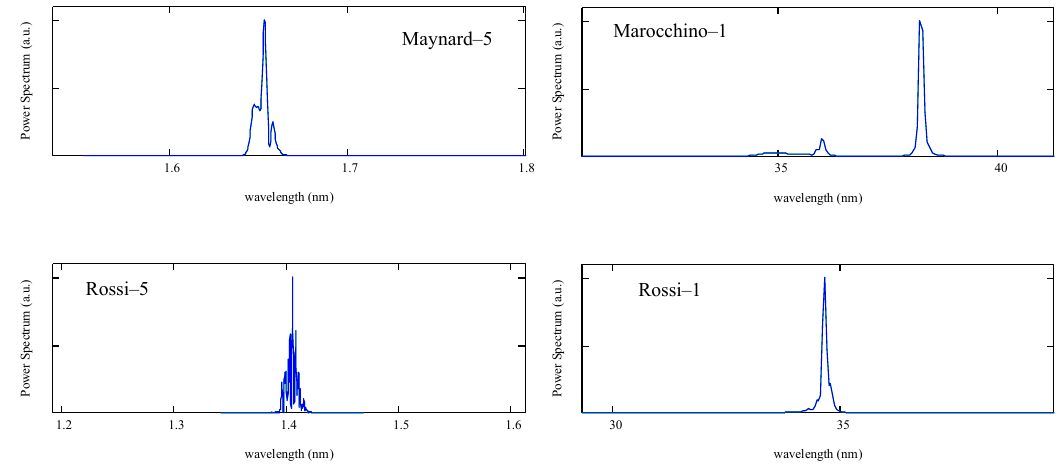
Figure 7. Wavelength spectra at saturation of the specified beam distributions, for the fundamental